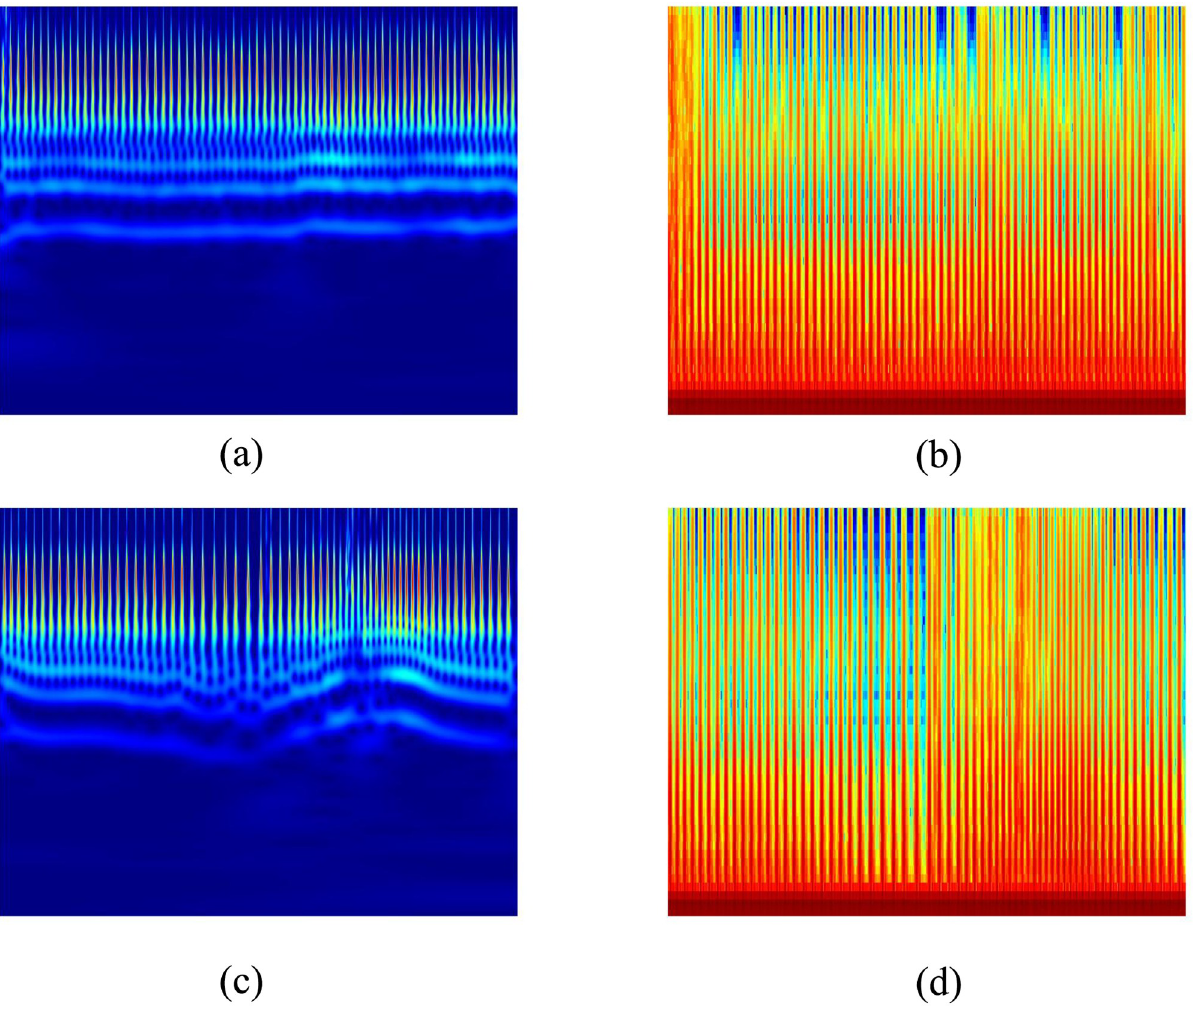
Fig 4. One-minute ECG segments transformed into (128, 128, 3) RGB images. (a) Scalogram image of a normal ECG segment. (b) Spectrogram image of the normal segment. (c) Scalogram image of an apnea ECG segment. (d) Spectrogram image of the apnea segment.